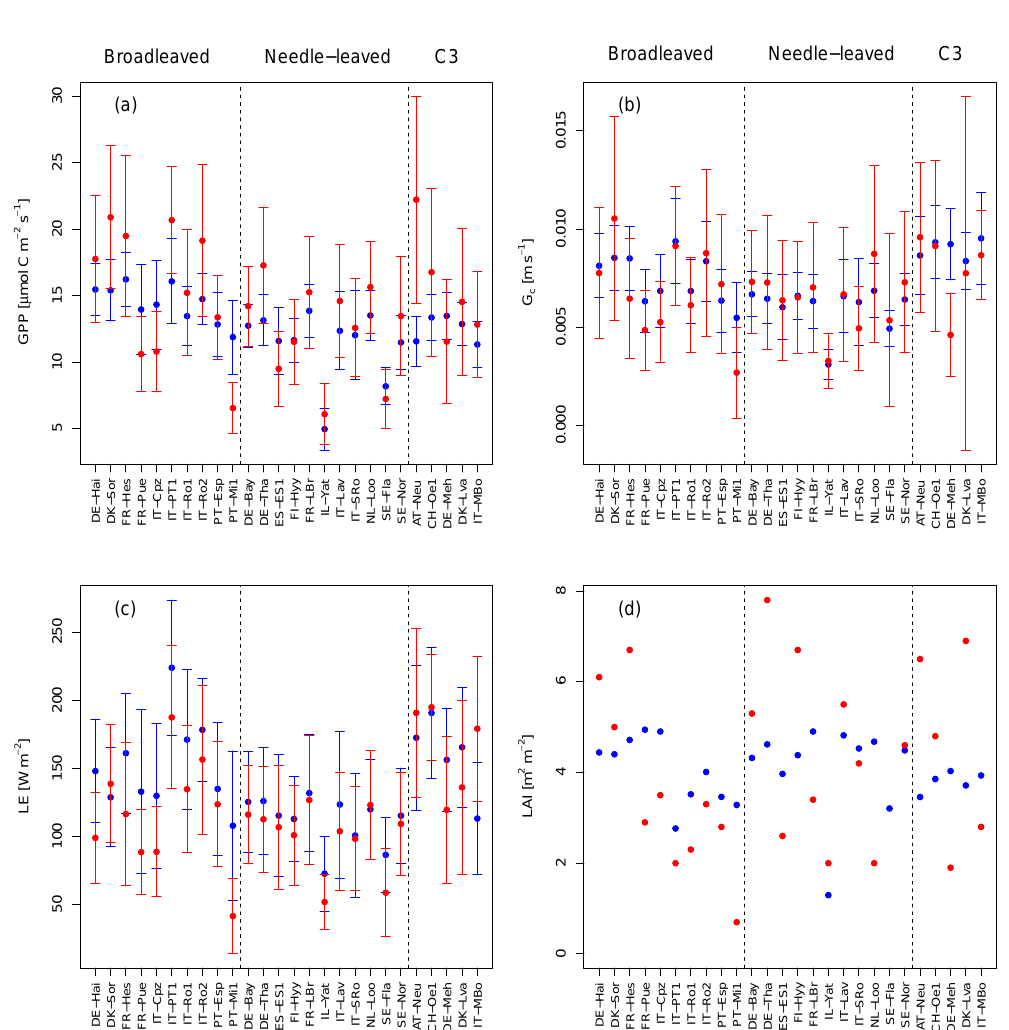
Figure A1. Comparison of measured (a) GPP, (b) G c , (c) latent heat flux (LE), and (d) LAI at 26 European FLUXNET sites (red) and simu- lations by OCN (blue). Displayed are means and standard deviation of daily means of the measuring/simulation period, with the exceptions of FLUXNET-derived LAI, which is based on point